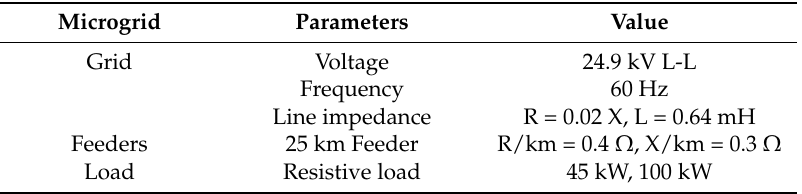
Table A1. Grid, feeders, and load types in the microgrid.